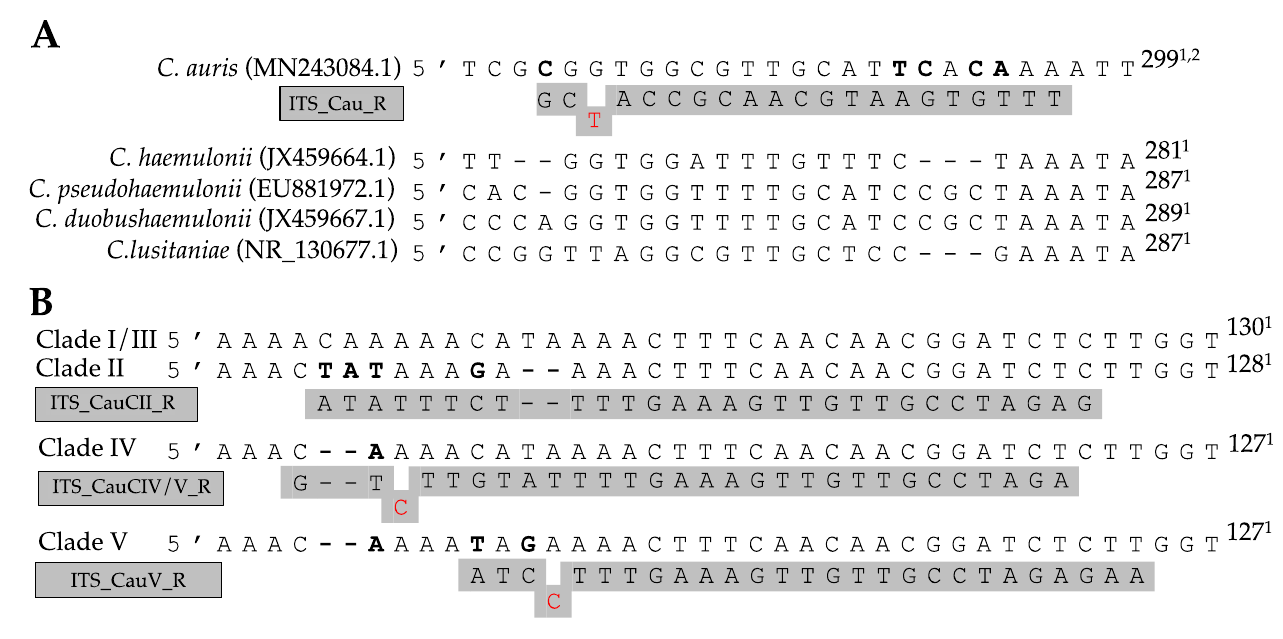
Figure 1. Allele-specific primer binding sites in the ITS region for the identification of C. auris ( A ) and C. auris clades ( B ). Specific polymorph nucleotides are shown in bold, primers are shown in gray, and mismatches contained within the primer are shown in red. 1 Nucleotide position from ITS1 forward primer. 2 Length based on ITS region of clade I.